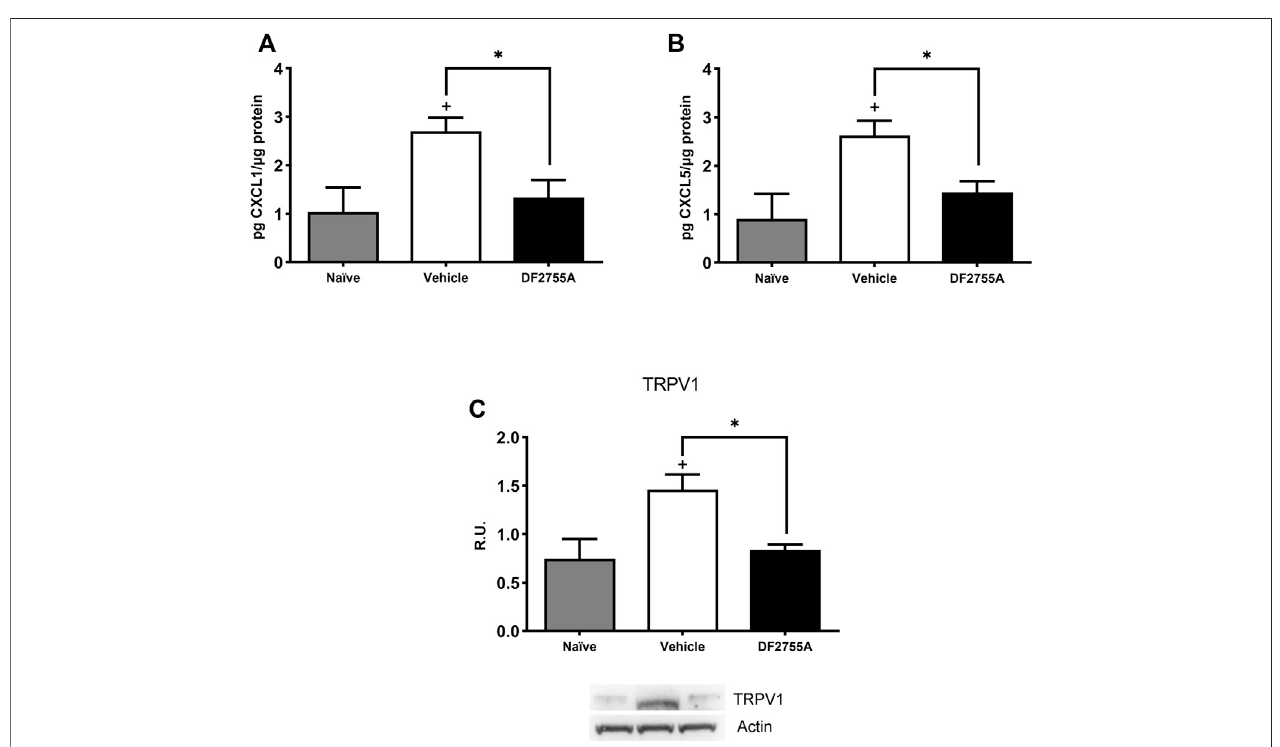
FIGURE 5 | DF2755A preventive treatment inhibited CXCL1/CXCL5 production and TRPV1 receptor expression in IC bladder tissue. Rats were orally pretreated with repeated vehicle or DF2755A (20 mg kg − 1 12 h before the fi rst CYP injection +7 mg kg − 1 twice daily for 7 days) administrations. After 24 h of the last CYP injection, animals were killed, and bladders were removed and processed asdescribed in Methods. CXCL1 (A) and CXCL5 (B) protein expression in whole urinary bladder tissue wasdeterminedwithELISAsinnaïverats,CYP-plusvehicle-treatedrats(vehicle),andCYP-plusDF2755A-treatedrats(DF2755A).Dataareexpressedaspgµg − 1 of protein (mean values ± SEM; n = 5 per group). TRPV1 receptor expression was evaluated in bladder homogenates by Western blotting analysis and relative densitometric analysisas described in Methods. Arepresentative band isreported (C) . Data are expressed as relative units (R.U.; mean values ± SEM; n = 5 per group). * p < 0.05 versus Vehicle group, + p < 0.05 versus Naïve group (ANOVA